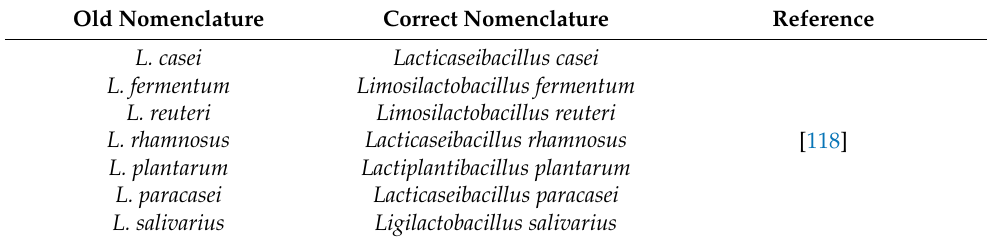
Table 4. Correct nomenclature of Lactobacillus